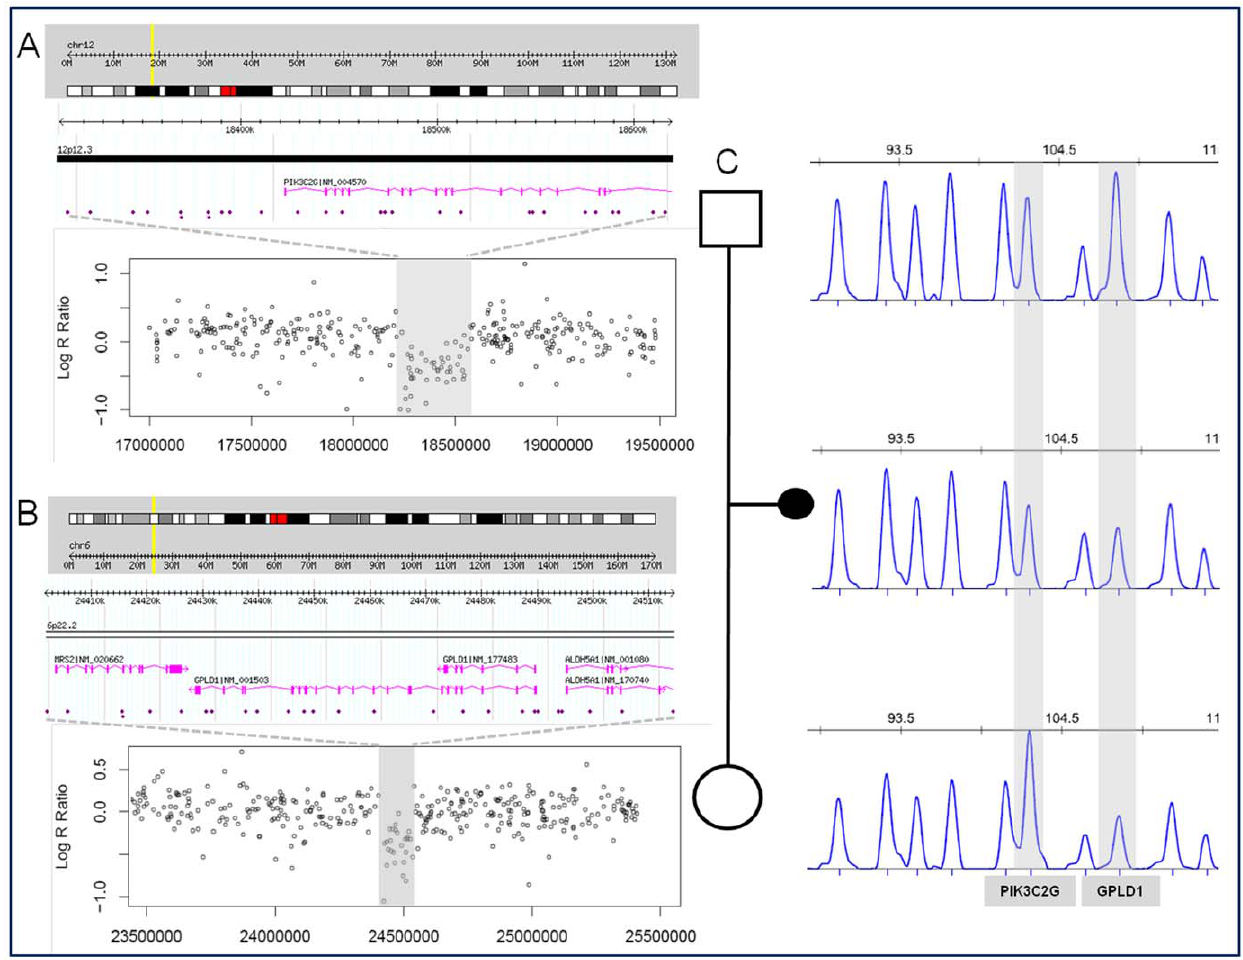
Figure 2. Detection, validation and inheritance of the two chromosomal deletions in case 57. A and B: Ideogram showing the location of the rearrangement and the corresponding regional plot of the Log R Ratio values of the SNP array (deleted and flanking regions). C: MLPA pattern in the familial trio showing the inheritance of both deletions. Hg19 assembly. MLPA: multiplex ligation-dependent probe amplification; SNP: single nucleotide